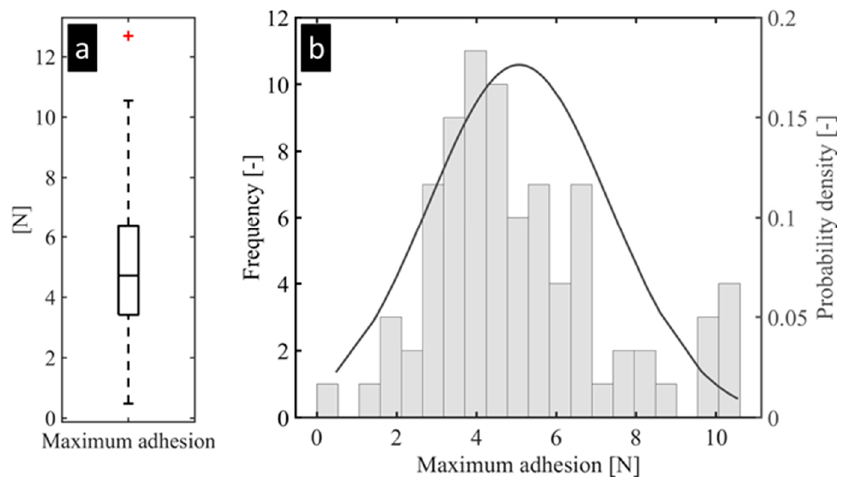
Figure 7. ( a ) Box plot, outlier as red crosses, and ( b ) histogram and probability distribution for maximum attachment strength of individual mussels in a sample of 82 mussels. maximum attachment strength of individual mussels in a sample of 82